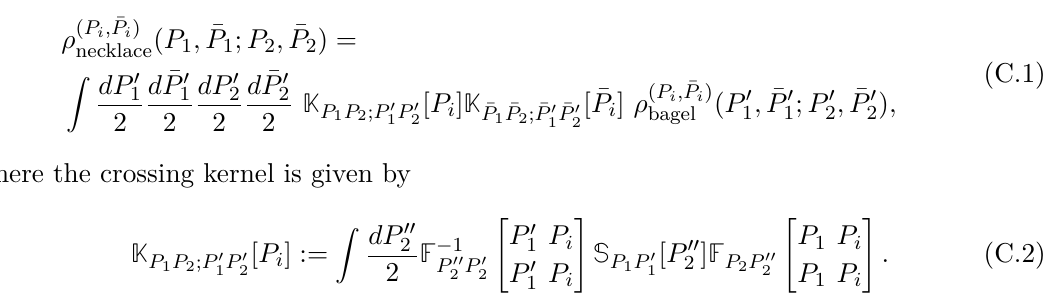
particular case of identical external boundary operators and identical boundary conditions at the two ends of the